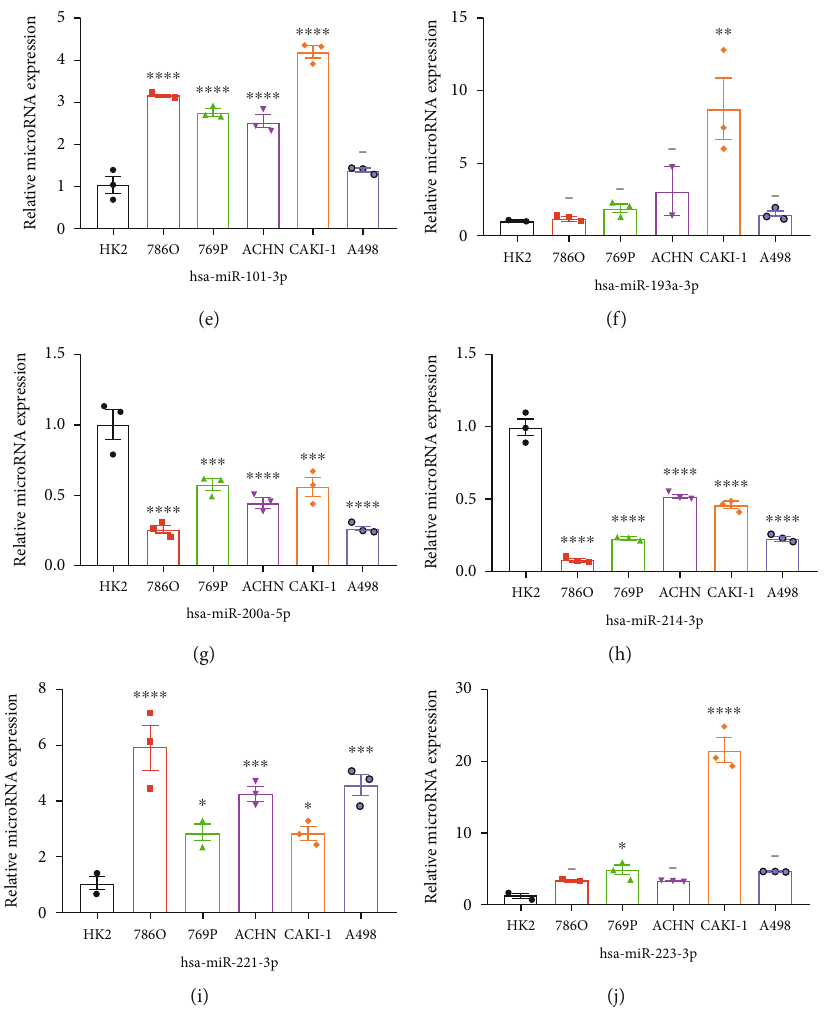
Figure 10: Prediction and veri fi cation of expression levels of 6 necroptosis-related miRNAs. (a, b) The expression levels of 6 necroptosis- related miRNAs between normal and tumor tissues predicted in TCGA-KIRC. (c, d) The expression levels of 6 necroptosis-related miRNAs in RCC tissues veri fi ed by RT-qPCR. (e – j) The expression levels of each miRNA compared to U6 by RT-qPCR in the renal epithelial cell line (HK2) and 6 human renal cancer cell lines (786O, 769P, ACHN, CAKI-1 and A498). ( ∗∗∗ P < 0 : 001 ; ∗∗ P < 0 : 01 ; ∗ P < 0 : 05 ; -: no signi fi